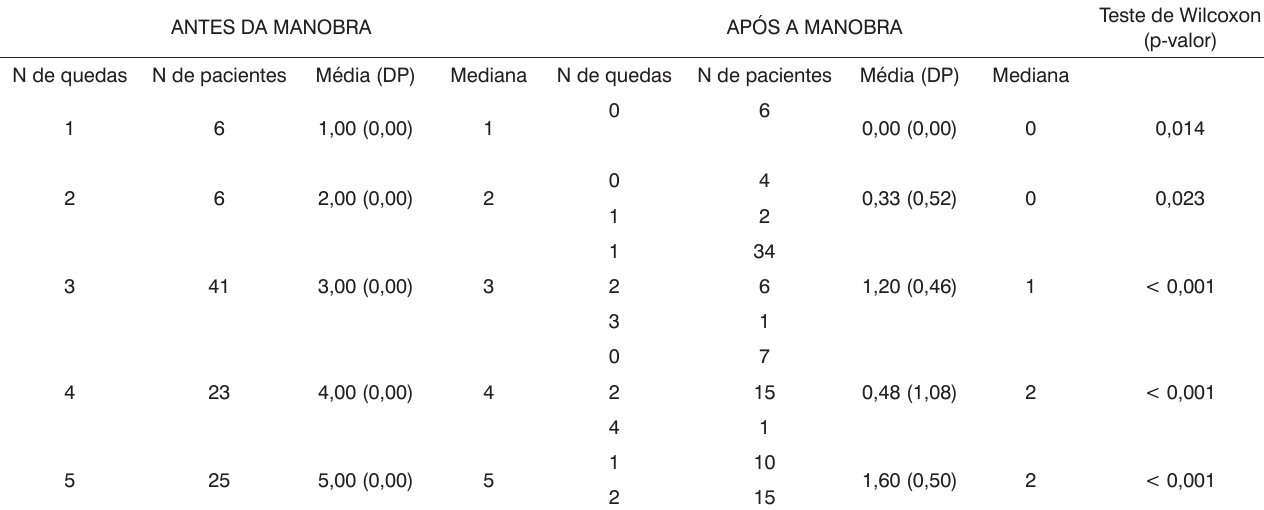
Tabela 3. Número de quedas antes e após o tratamento da Vertigem Posicional Paroxística Benigna em idosos por meio da manobra de Epley, nos casos com acometimento do canal semicircular posterior